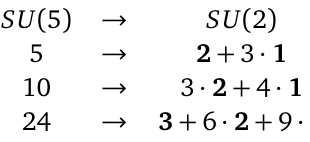
into representations of SU ( 5 ) a